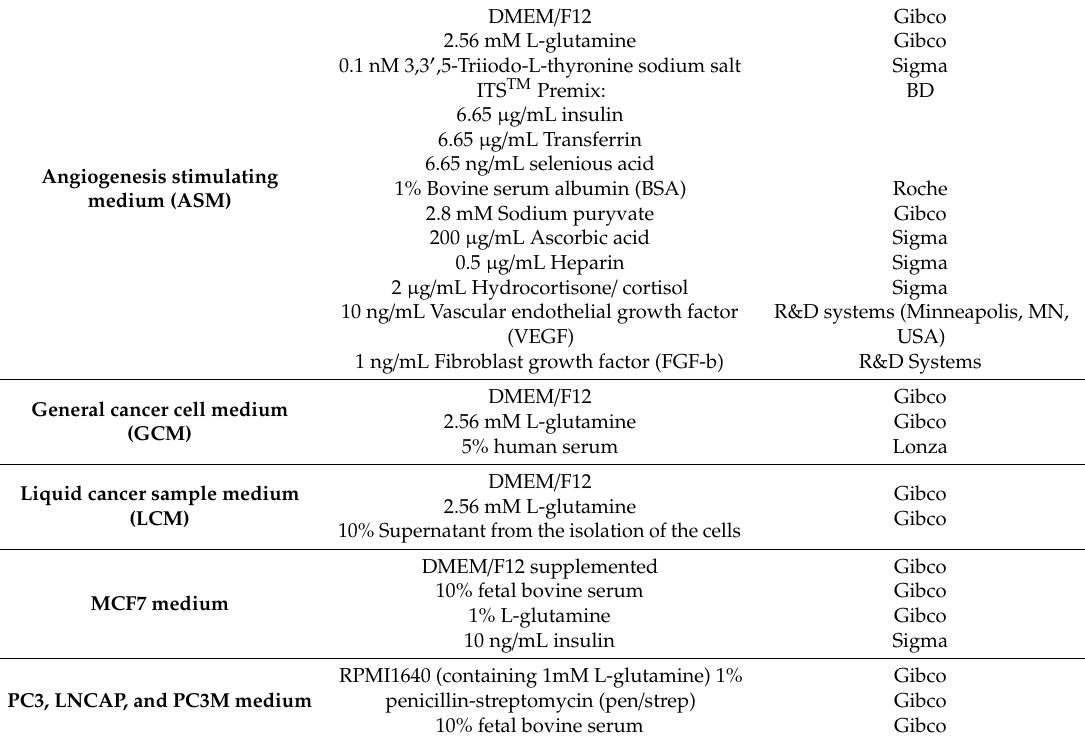
Table 3. Media used in the study.